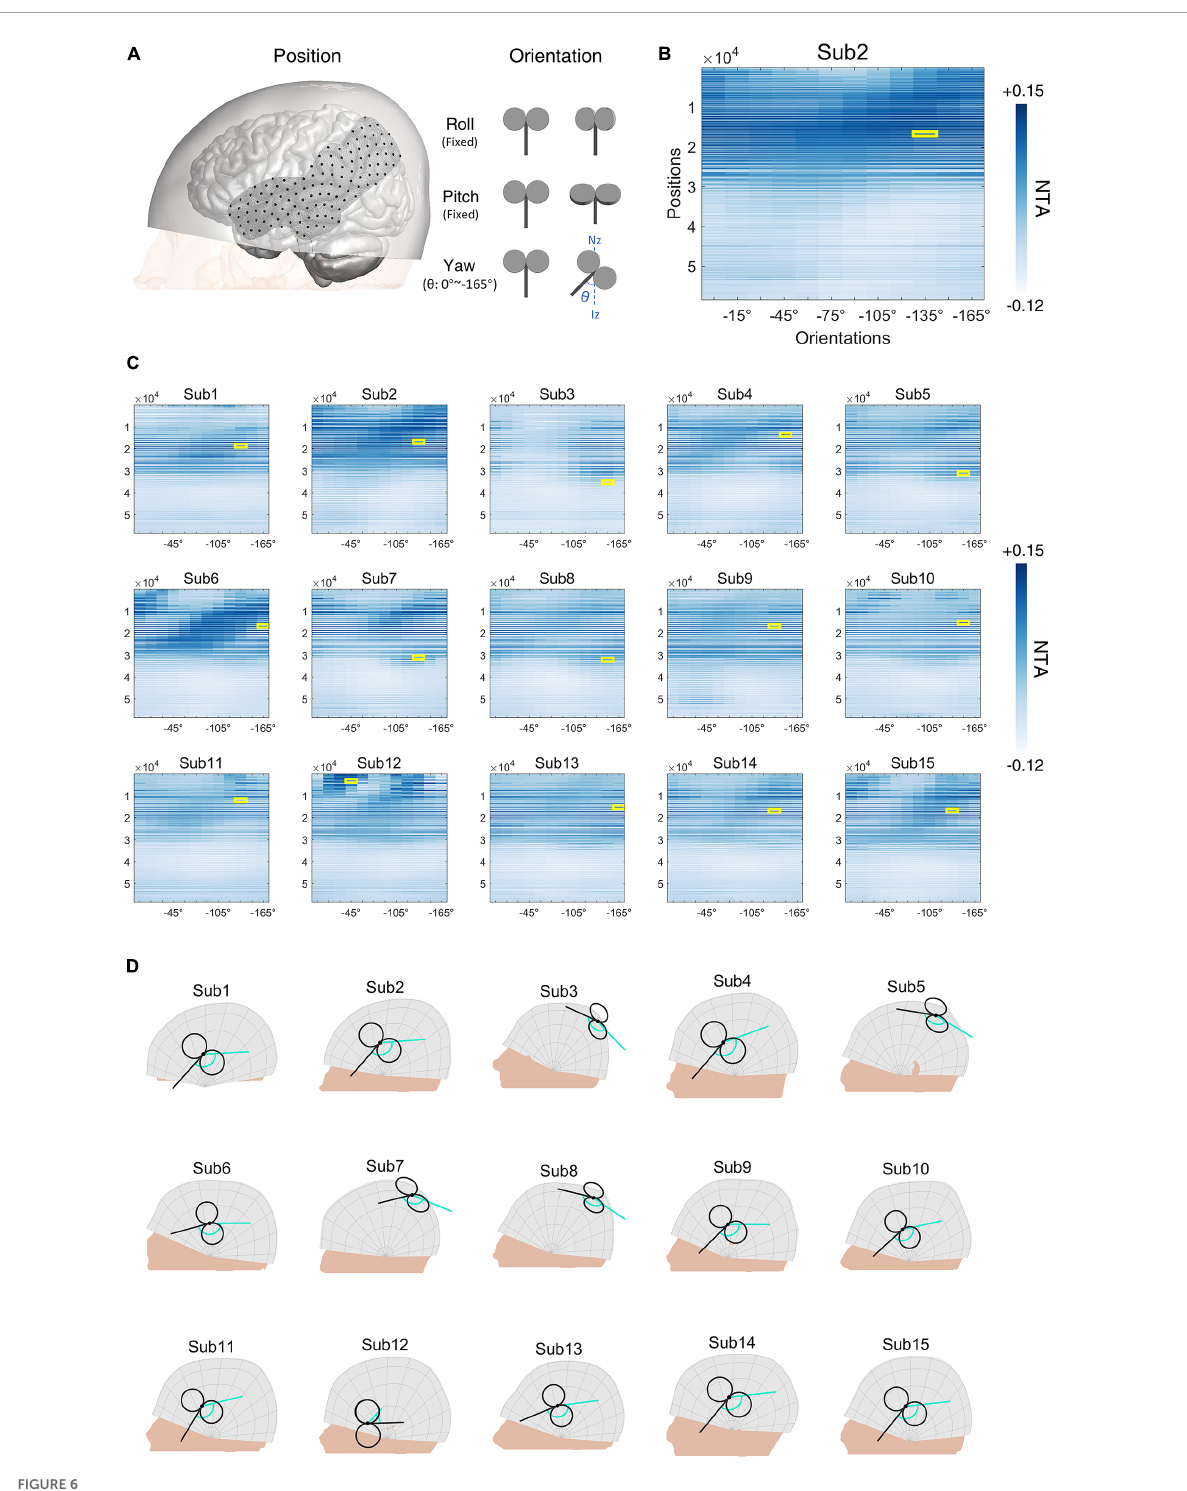
FIGURE6 Schizophrenia with auditory verbal hallucinations (AVH) simulation experiment. (A) Illustration of positions and orientations of a representative individual. Large black dots represent the 122 positions in the search space. For each position, 12 coil orientations (0 ◦ ∼− 165 ◦ , 15-degree intervals) were tested. Network targeting accuracy (NTA) was calculated for each pair of position and orientation. (B) NTA value distribution in the search grid. Each position in the 2-D grid represents a combination of position and orientation. (C) Maximum NTA found in all patients (yellow border). Search space was interpolated from 122 × 12 to 58,470 × 12 for visualization purposes. (D) The optimal transcranial magnetic stimulation (TMS) coil placements are shown in individual scalp spaces. The cyan arrow represents 0 ◦ at each